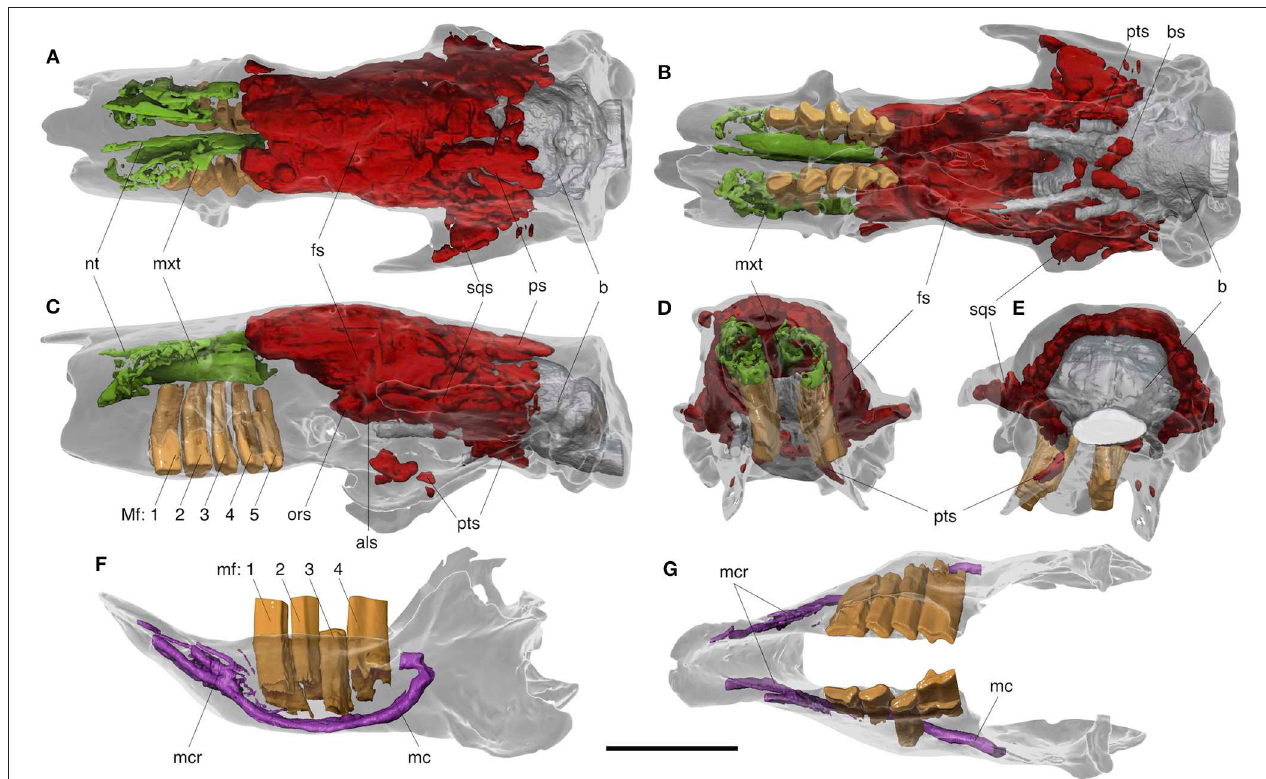
FIGURE 5 | Digital reconstructions of the skull and mandible of Catonyx tarijensis MNHN-Bol V 13364 from the Pleistocene of Oruro (Bolivian Altiplano), showing internal features. Skull in dorsal (A) , ventral (B) , lateral (C) , anterior (D) , and posterior (E) views. Mandible in lateral (F) and occlusal (G) views. als, alisphenoid sinus; b, brain endocast; fs, frontal sinus; mc, mandibular canal; mcr, mandibular canal ramifications; mf, lower molariform tooth; Mf, upper molariform tooth; mxt, maxilloturbinate; nt, nasoturbinate; ors, orbitosphenoid sinus; ps, parietal sinus; pts, pterygoid sinus; sqs, squamosal sinus. Colors indicate: green, turbinates; purple, mandibular canal and ramifications; orange, dentition; red, sinuses. Scale bar equals